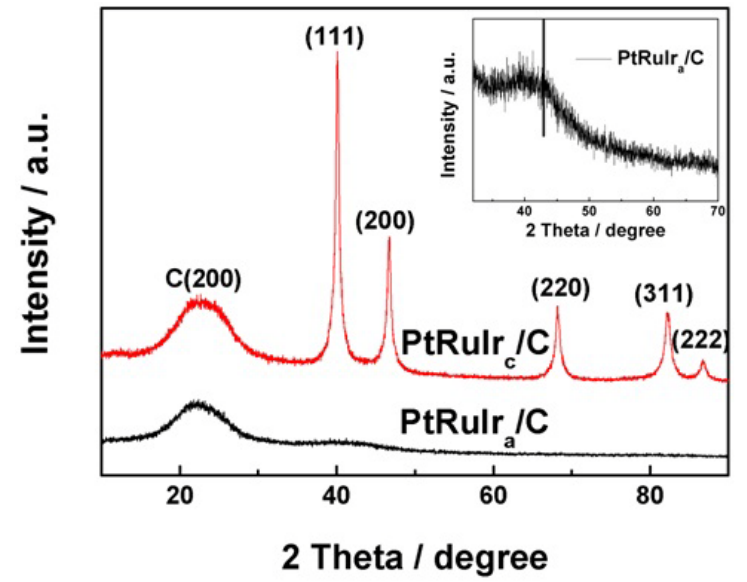
/C and PtRuIr /C c a